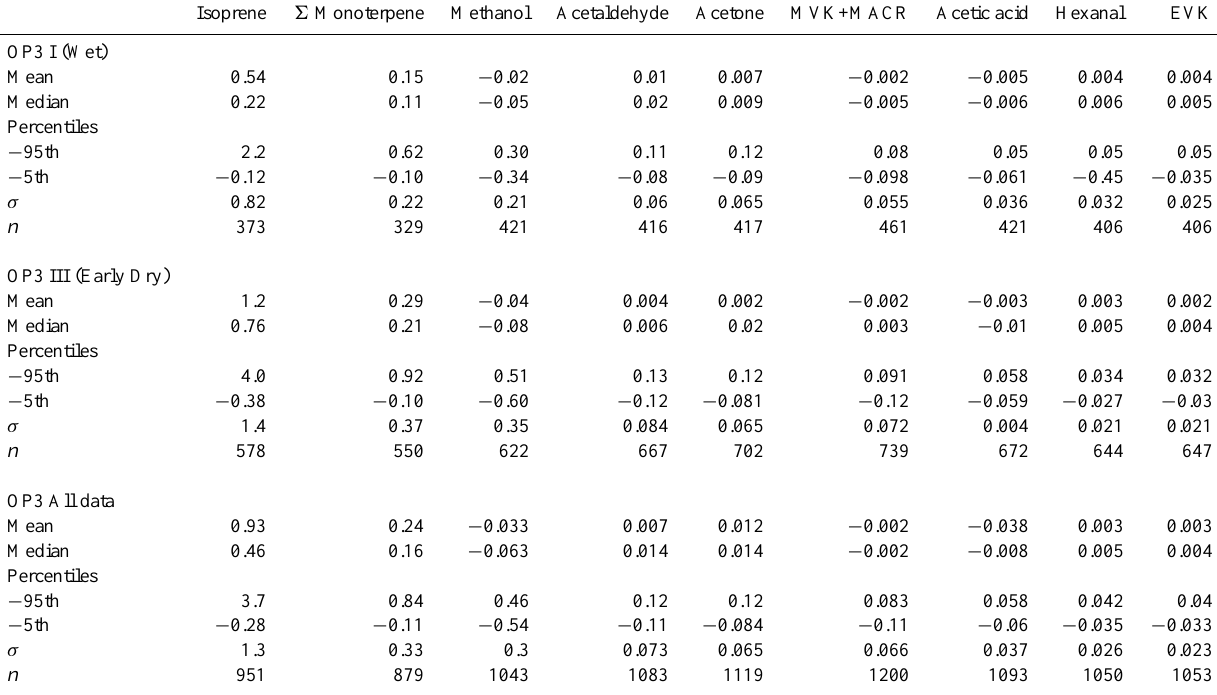
Table 2b. Summary of VOC fluxes (mg m − 2 h − 1 ) measured during the two intensive OP3 campaigns. Isoprene 6 Monoterpene